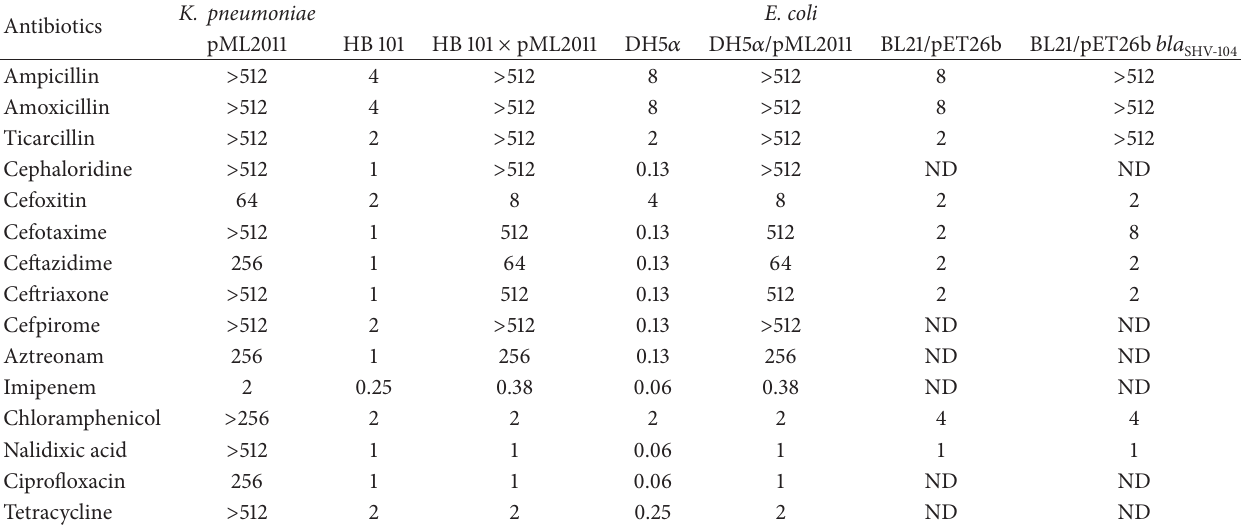
Table 2: MICs of various antimicrobial agents obtained for the clinical isolate K. pneumoniae ML2011, transformants, transconjugants, and the E. coli recipients.